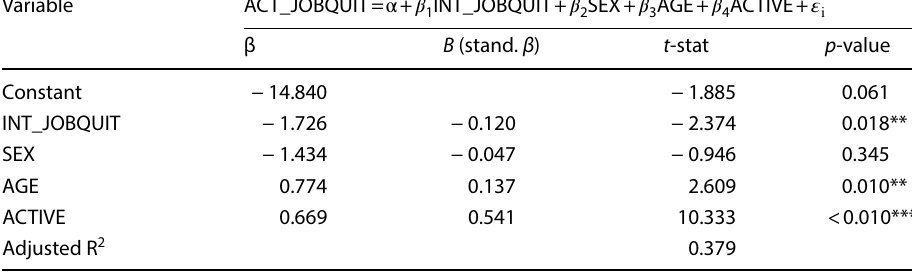
Table 3 Results of the regression analysis for the impact of frequent job- quitting intentions on career starters’ actual